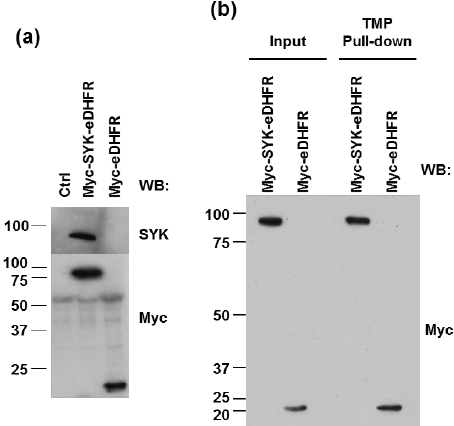
Figure 1. eDHFR-linked fusion proteins are stable and bind trimethoprim (TMP). ( a ) HEK293T cells were transfected with either recombinant Myc-SYK-eDHFR or control Myc-eDHFR plasmids and stable transfectant cell lines were produced. Western blot (WB) analysis of lysates from control HEK293T cells (Crtl) or stable transfectant HEK293T cells using antibodies against SYK or the Myc-epitope tag (Myc); ( b ) Lysates from HEK293T cells expressing Myc-SYK-eDHFR or Myc-eDHFR were adsorbed to immobilized TMP, shown in Figure 2a. Proteins in lysates (Input) or bound to beads were detected by Western blotting using anti-Myc epitope (Myc) antibodies.